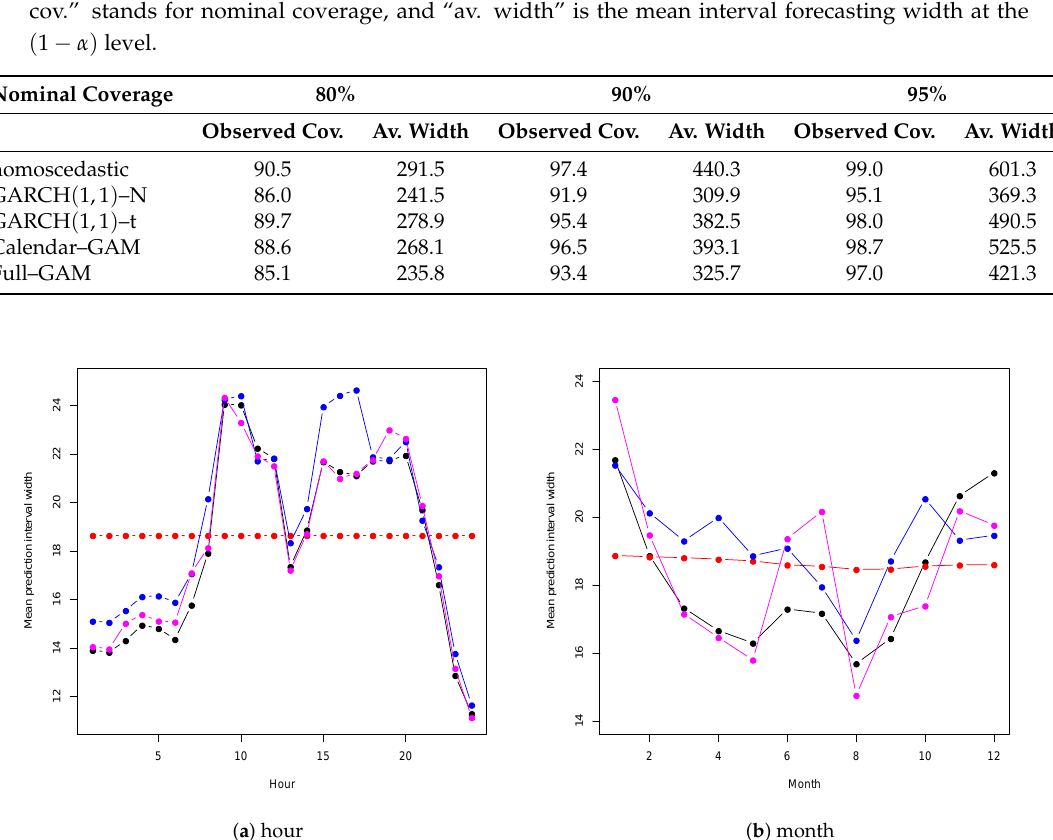
Figure 12. Average width of the prediction intervals for each hour of the day is shown in ( a ) and each month of the year is shown in ( b ). In both panels, the ( red ) line denotes the average widths of the homoscedastic model, the ( blue ) line of the GARCH ( 1,1 ) -N model and the ( black ) and ( magenta ) lines for the Calendar-GAM and Full-GAM,